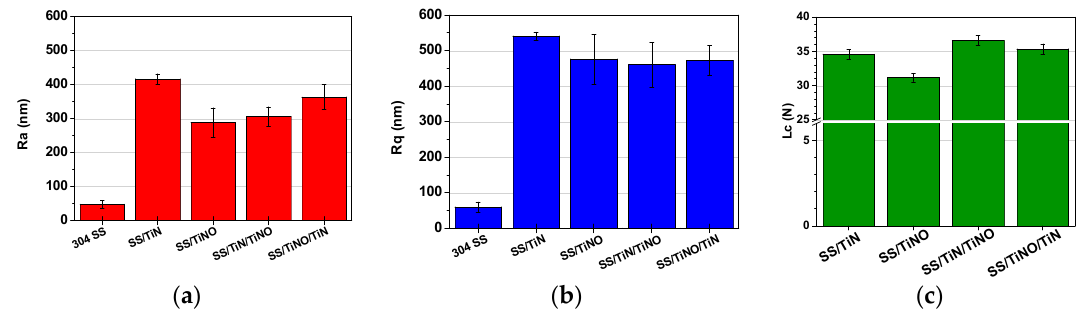
Figure 2. Roughness parameters and coatings adhesion: ( a ) R a –arithmetic average deviation from the mean line (Ra); ( b ) R q –the root mean square average of the profile heights over the evaluation length; ( c ) L c -critical load, at which failure of the coating took place.